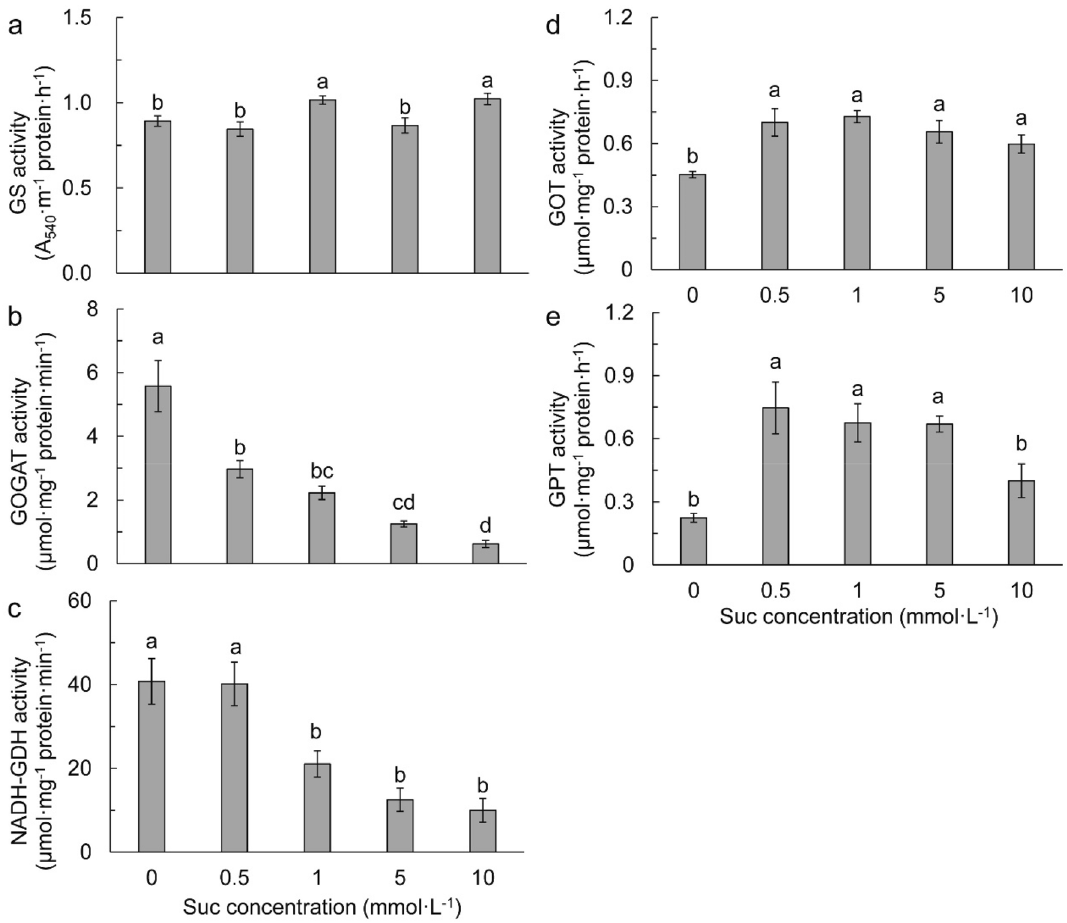
Figure 4. Glutamine synthase (GS, a ), glutamate synthase (GOGAT, b ), NADH-dependent glutamate dehydrogenase (NADH-GDH, c ), glutamic–oxalacetic transaminase (GOT, d ), and glutamic–pyruvic transaminase (GPT, e ) activities in different sucrose concentrations. Data refers to means ± SE ( n = 4). Bars with the same letter are no statistically significantly difference at P < 0.05 by Duncan’s new multiple range